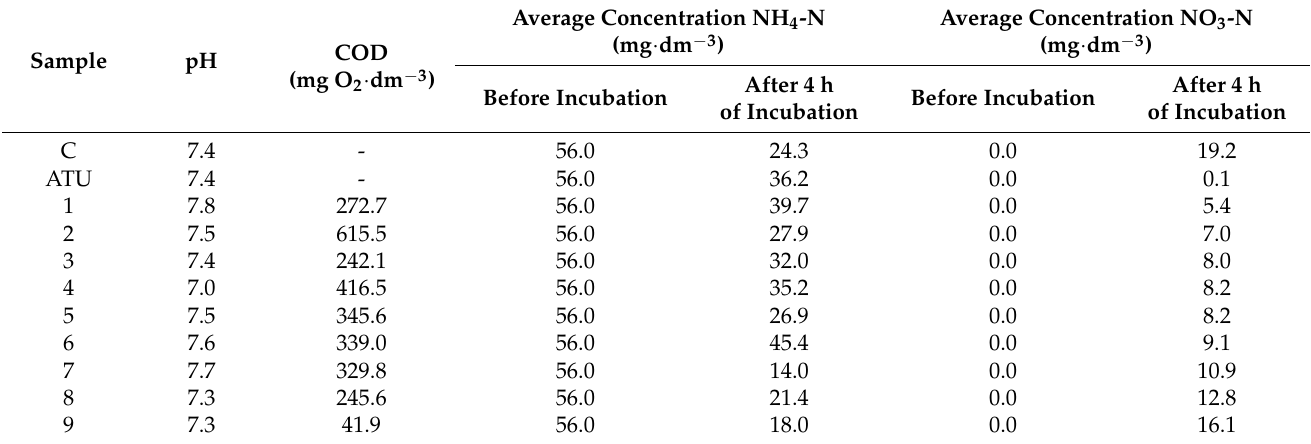
Table 3. Influence of industrial wastewater on the nitrification inhibition process in activated sludge.